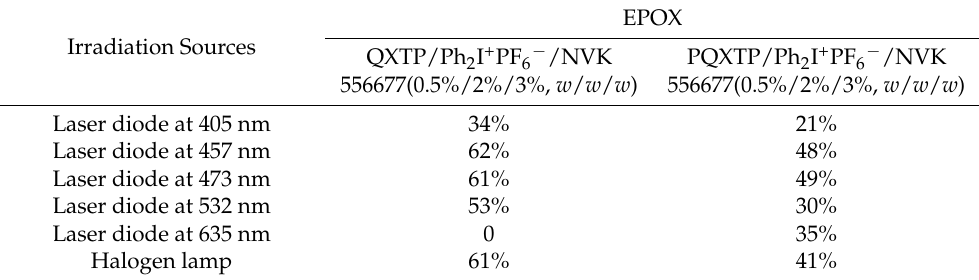
Table 9. Monomer conversions obtained during the CP of EPOX using the three-component QXTP/Ph 2 I + PF 6 − /NVK (0.5%/2%/3% w / w / w ) and PQXTP/Ph 2 I + PF 6 − /NVK (0.5%/2%/3% w / w / w ) systems.